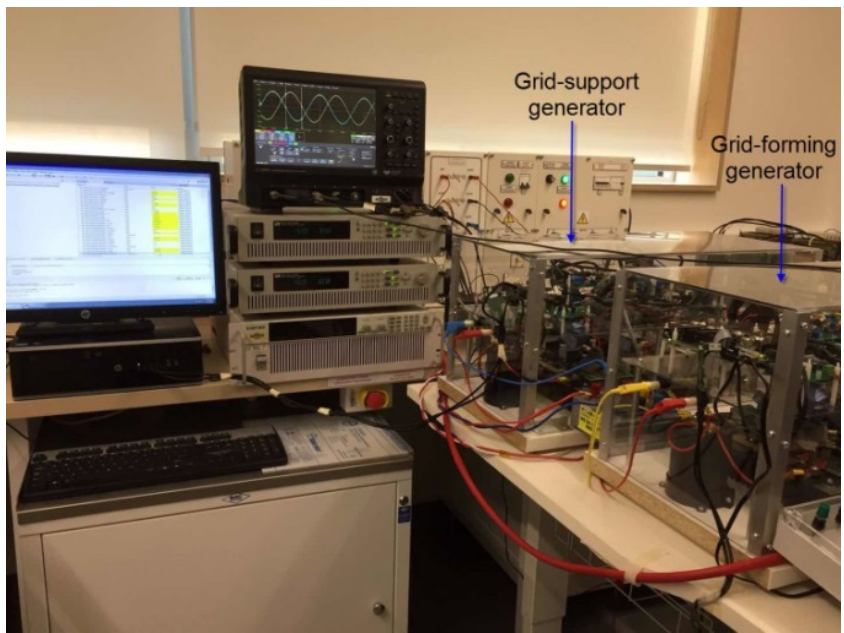
Figure 6. Second-order system in simulation.